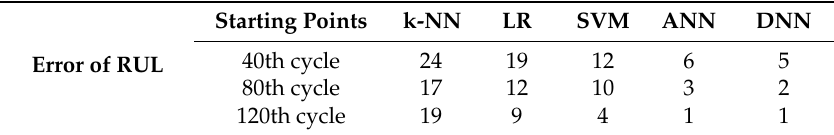
Table 6. The error of RUL estimation by using DNN and traditional machine learning algorithms. Starting Points Error of RUL